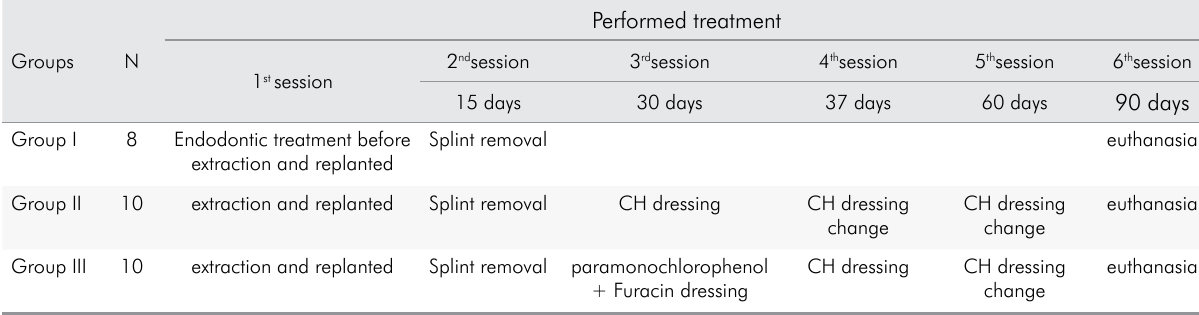
Table 1. Study treatment sequence.